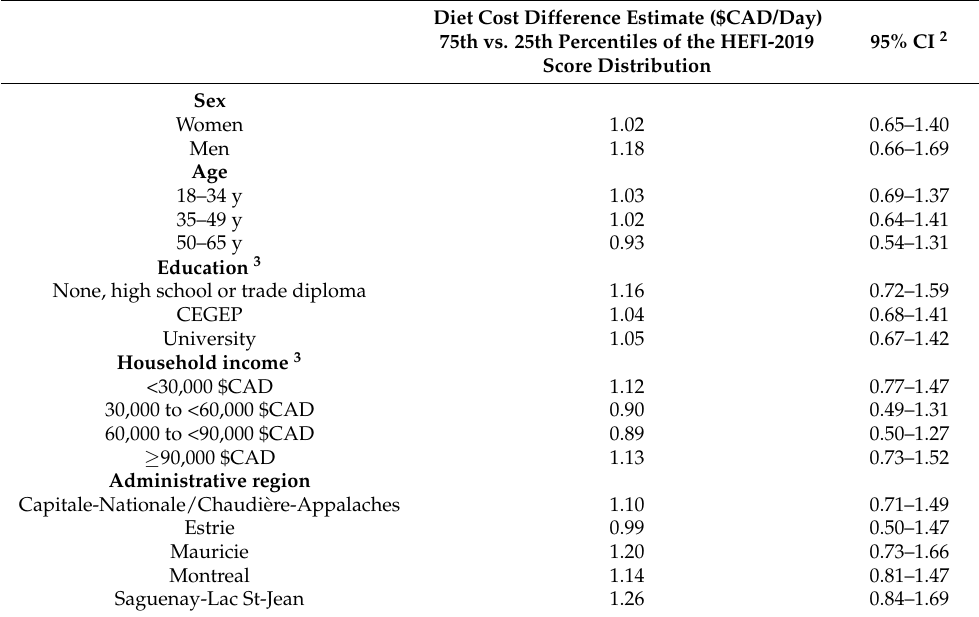
Table 2. Estimated diet cost difference between high vs. low HEFI-2019 scores in 1147 French- speaking adults from Quebec according to sociodemographic characteristics 1 .